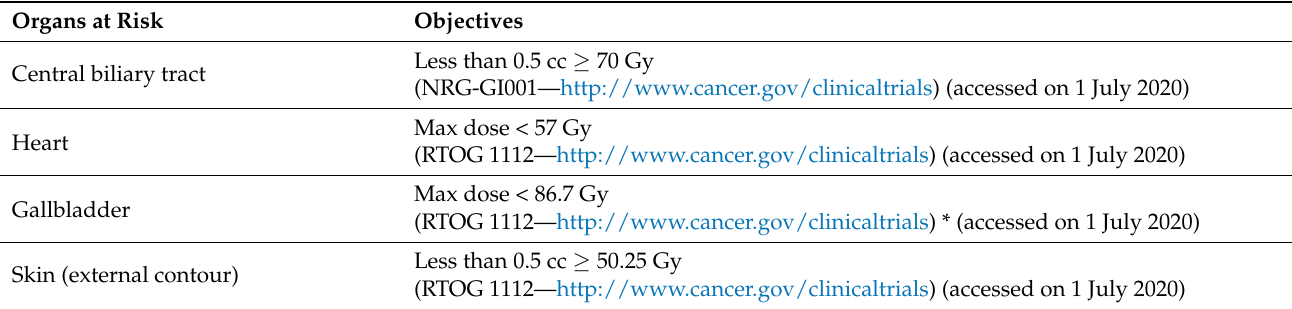
Table 2. Organs at risk